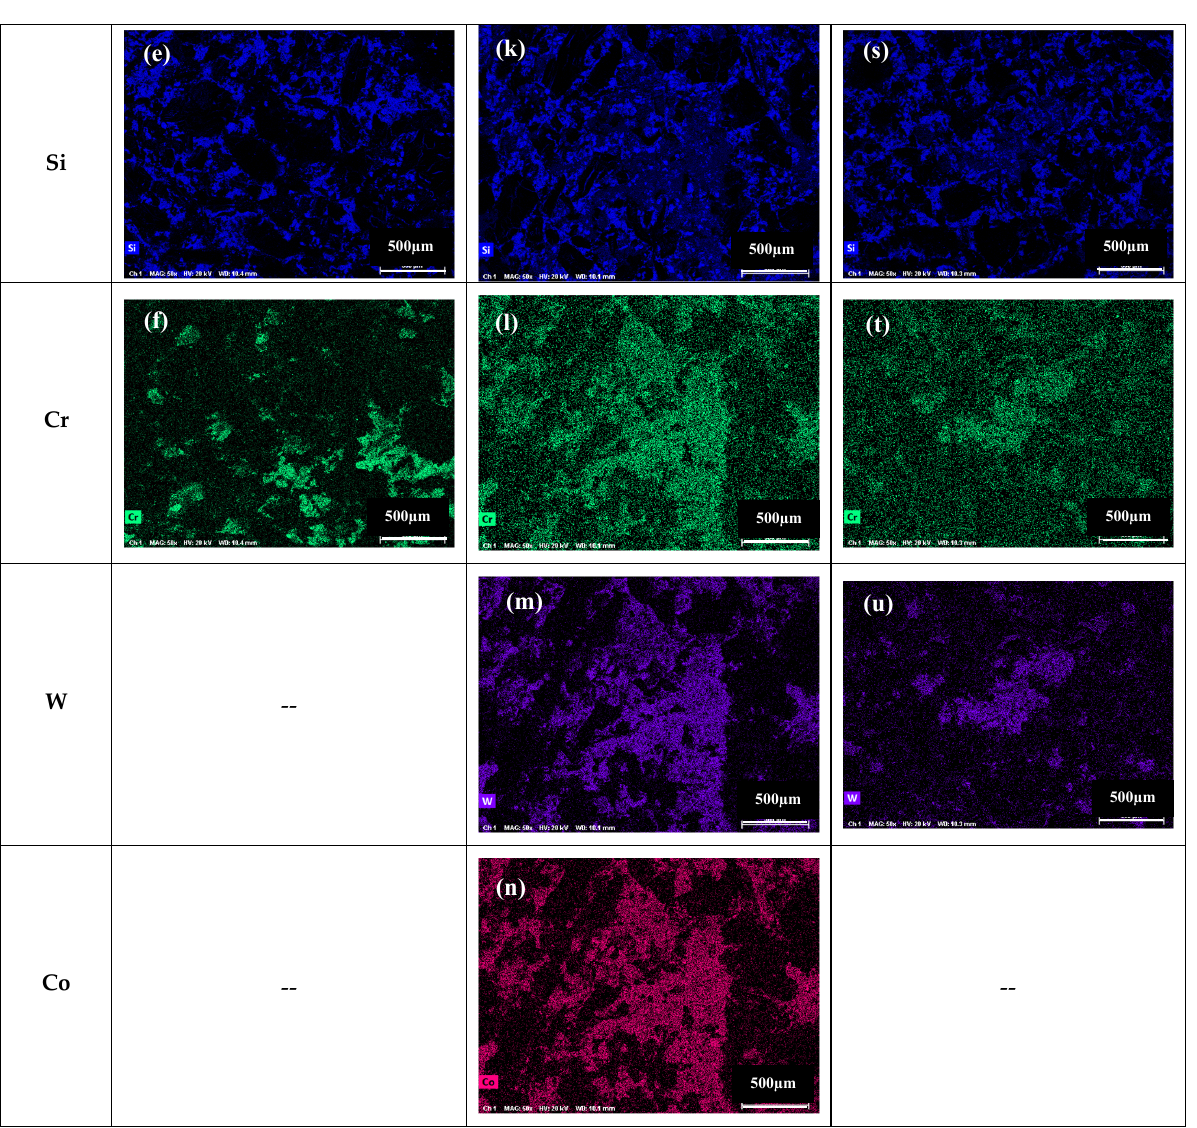
Figure 9. Worn top view and corresponding EDXS maps of the pin surface after PoD testing with (a ‐ f) Uncoated disc, (g ‐ n) WC ‐ CoCr coated disc, (o ‐ u), WC ‐ FeCrAlY coated disc .